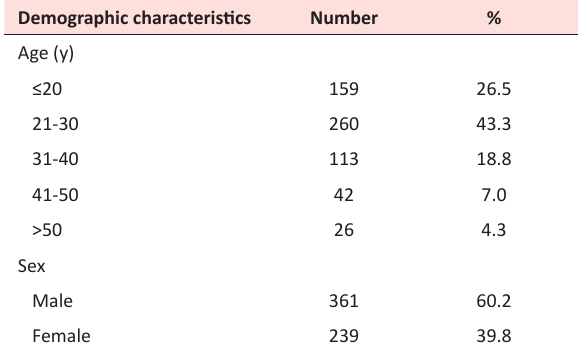
Table 1. Demographic characteristics of poisoning cases (n = 600) Demographic